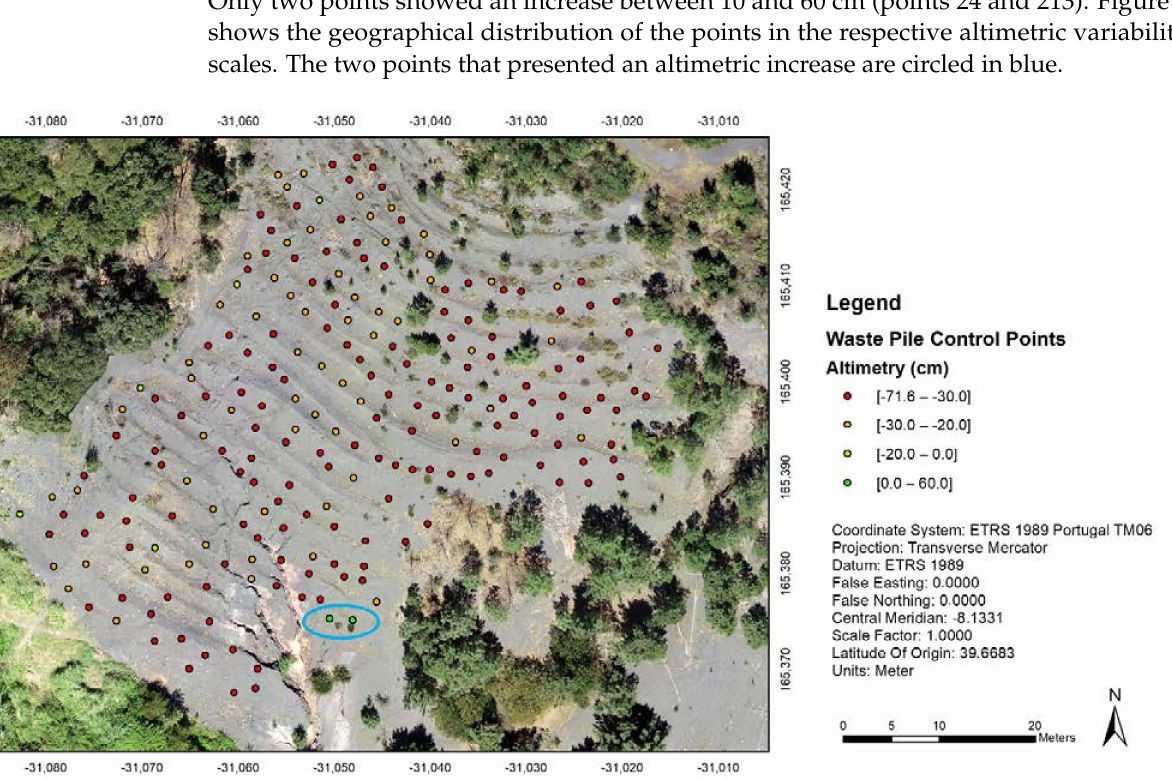
Figure 9. Geographical representation of the altimetric